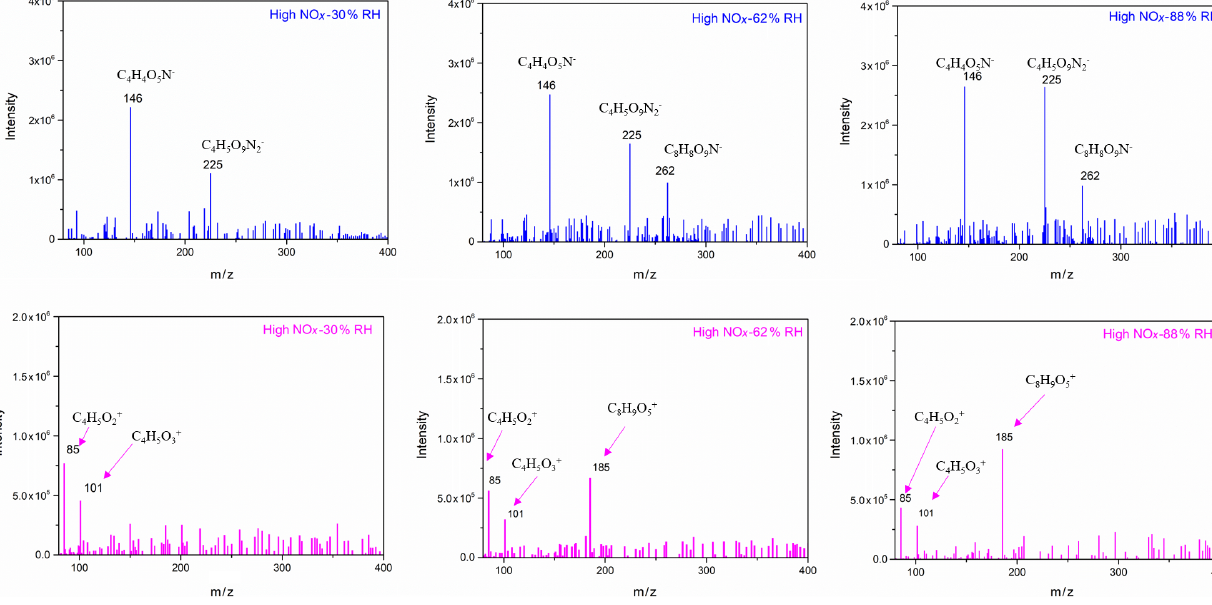
Figure 8. Selected background-subtraction HESI-Q Exactive-Orbitrap MS results of SOA in both negative (blue) and positive (pink) ion modes from the photooxidation of furan under different RH